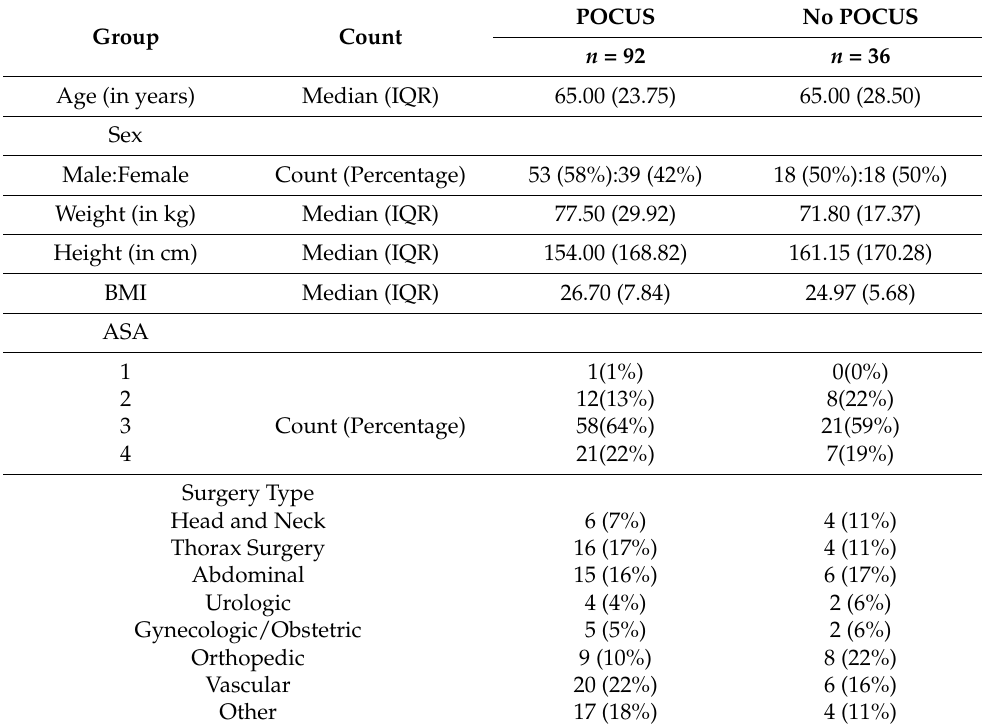
Table 1. Demographic and surgery type